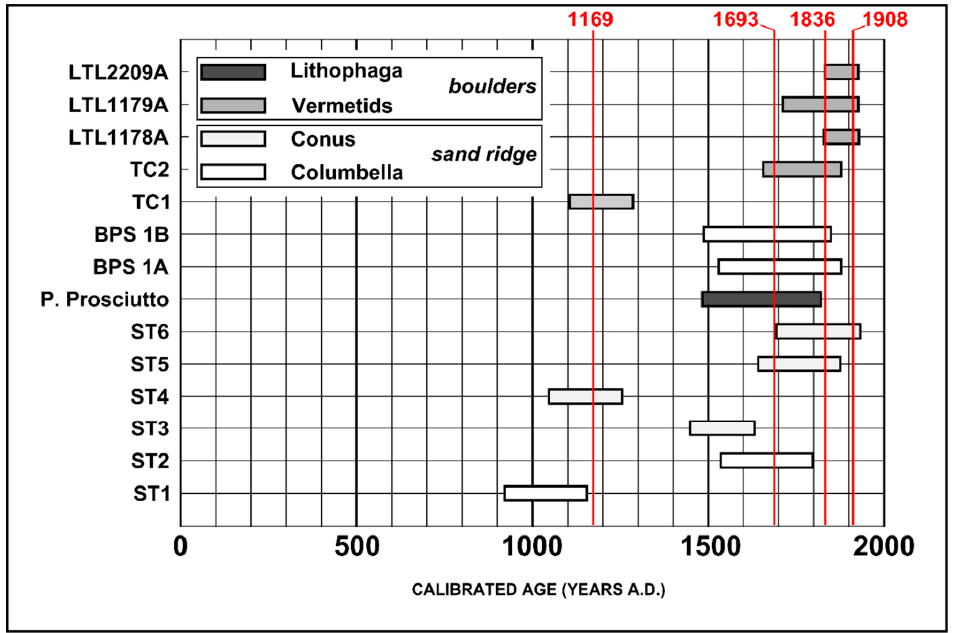
Figure 12. AMS radiocarbon age of samples collected at Profile S1 of the sand ridge (from ST1 to ST6) compared with chronological data available in the literature for the same site or surrounding areas (see Table 2). The dates of tsunami events occurring in the Ionian Sea since 1000 A.D. are also reported (red lines; from [2]).